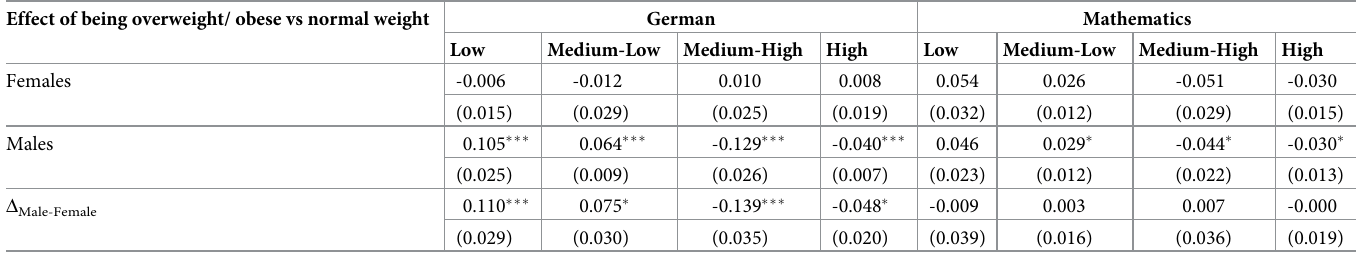
Table 2. Teachers’ grading bias (measured in average partial effects) over the grades distribution, according to students’ BMI and gender. Effect of being overweight/ obese vs normal